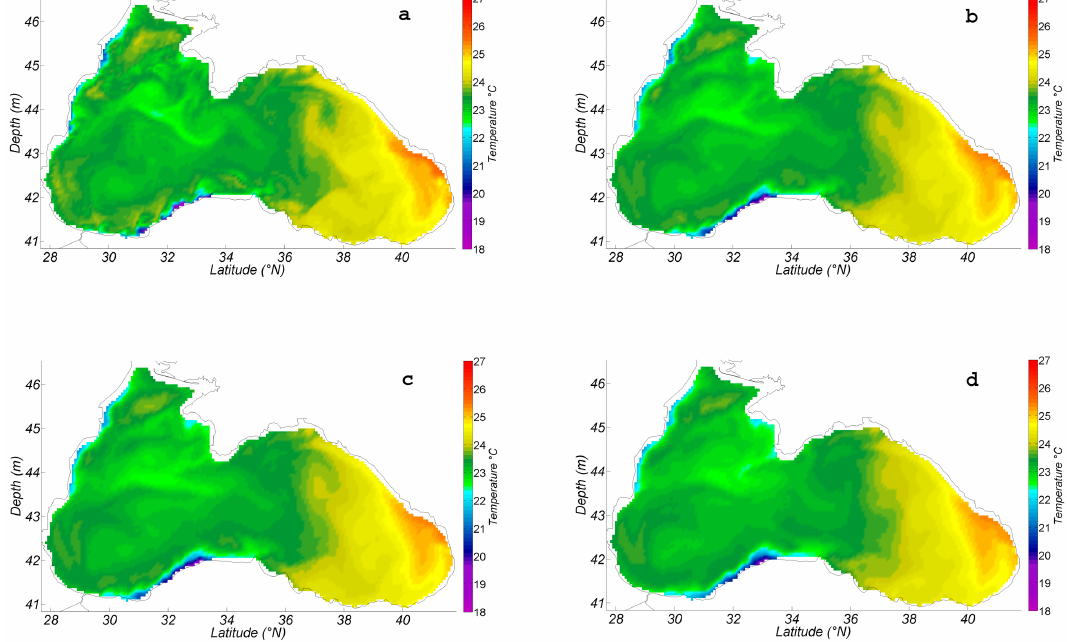
Fig. 9. Sea surface temperature for 7 July 2007 computed with the SZHENV hybrid vertical grid from identical climatic initial conditions for January and SKIRON meteorological forcing, and various Smagorinsky diffusivities in accordance with Table 1: (a) SHD1; (b) SHD2; (c) SHD3; (d)